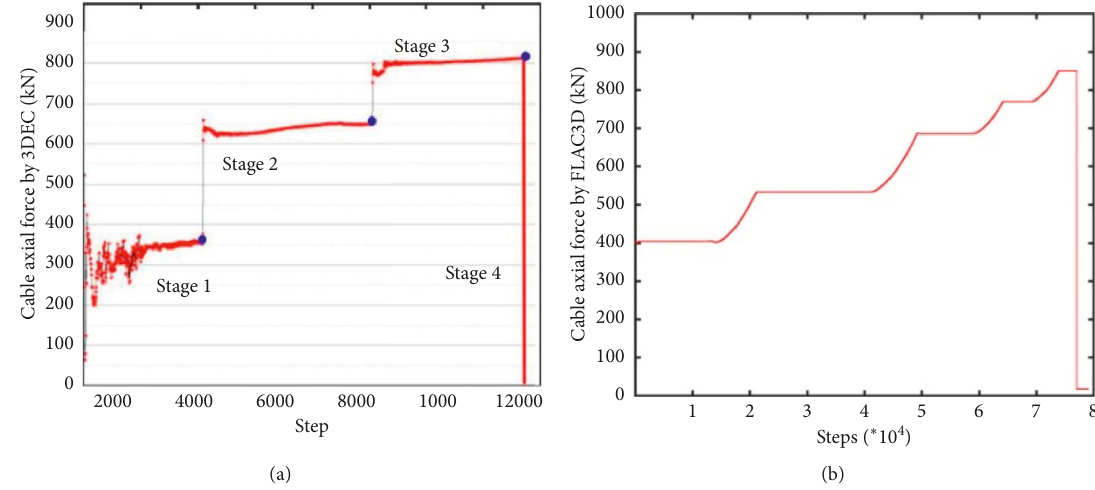
Figure 31: Comparison of the axial force variation curve of the NPR anchor cable.